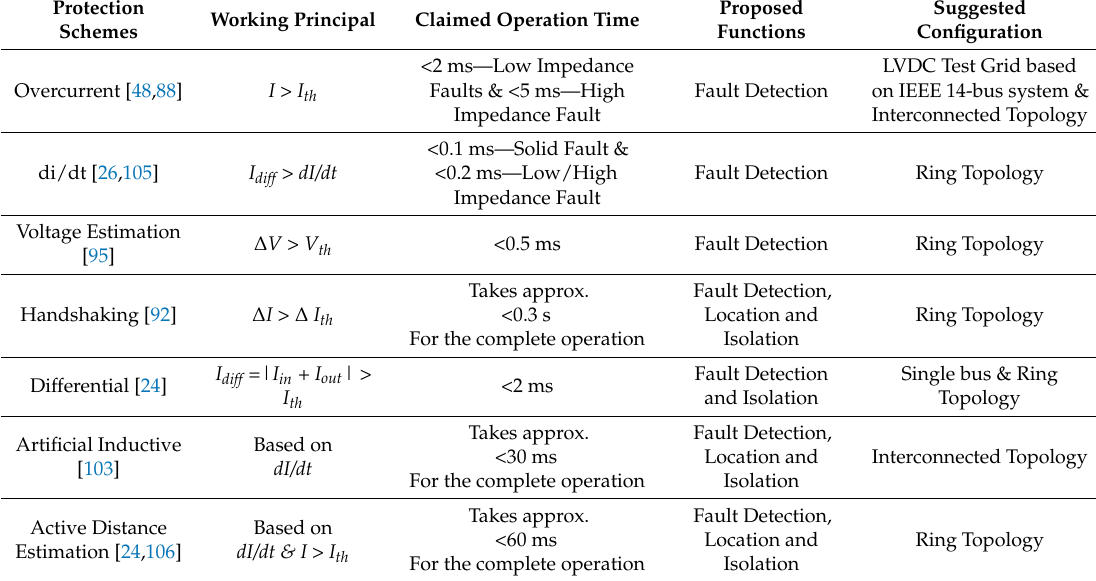
Table 1. Comparison of Different Protection Schemes for LVDC